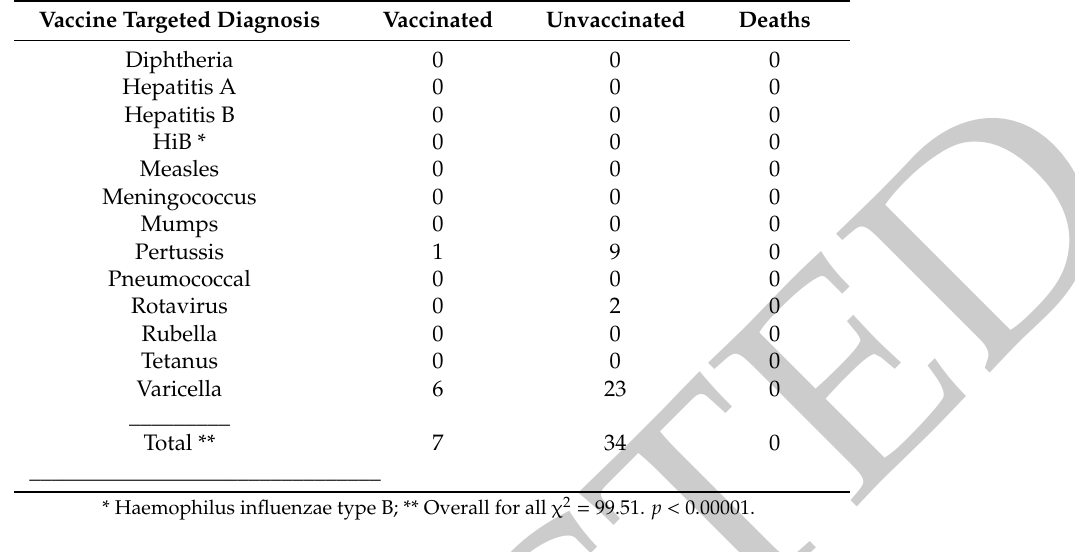
Table 7. Incidence of vaccine-targeted diagnoses in the study cohort. Vaccine Targeted Diagnosis